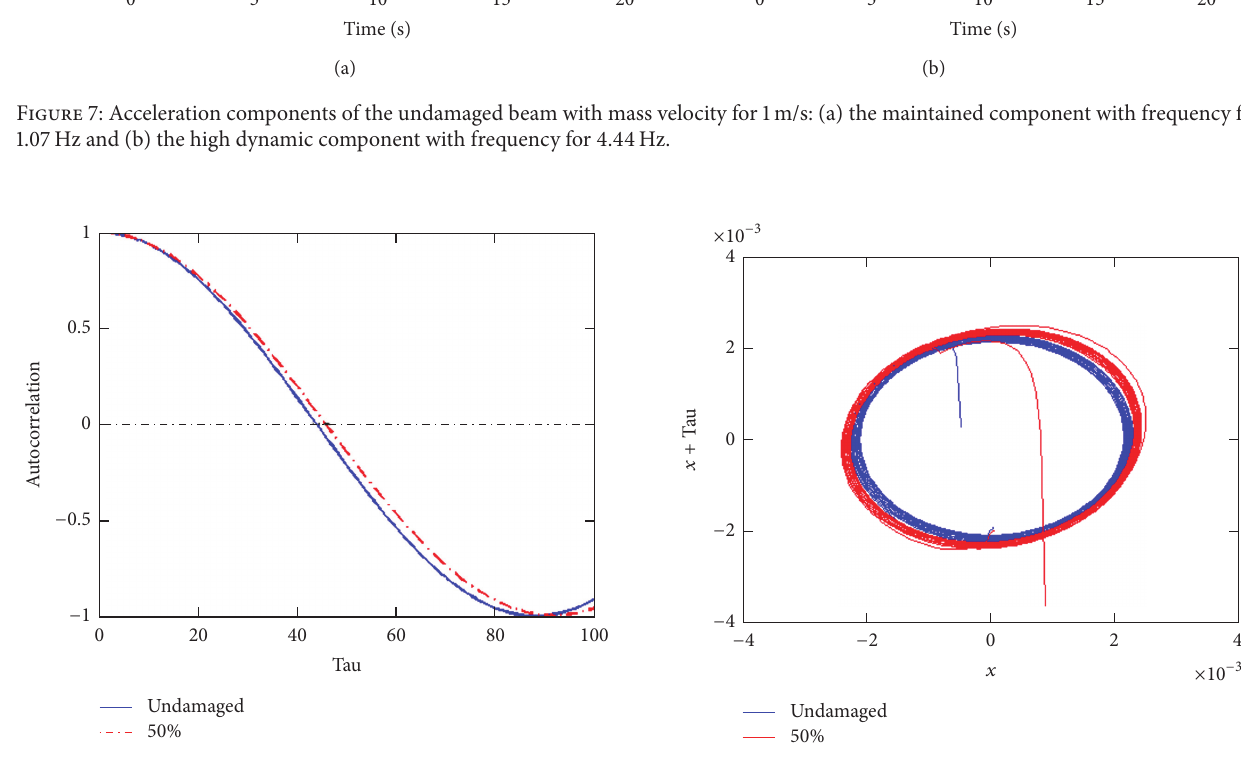
Figure 8: Autocorrelation function curve of the scenario with mass is 200 Kg and velocity is 1m/s: blue curve is for undamaged condition and red curve is for the 50% damaged one.